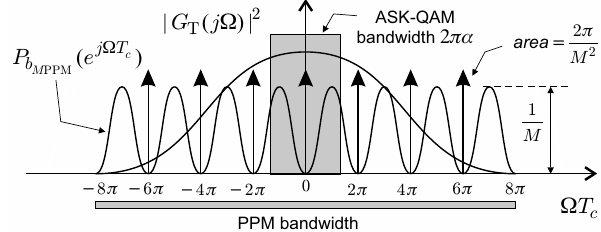
Figure 1. Power spectral density of M PPM signals. M position modulation (PPM) transmission, where M is the number of chips per symbol.